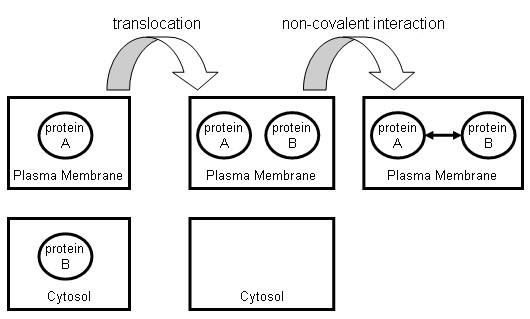
Interactions among biological structures of different levels in the SN. The left panel shows an example of a translocation event when a protein B is moved from the cytosol to the plasma membrane. The right panel shows an example of a non-covalent interaction between a protein A and a protein B via non-covalent forces.